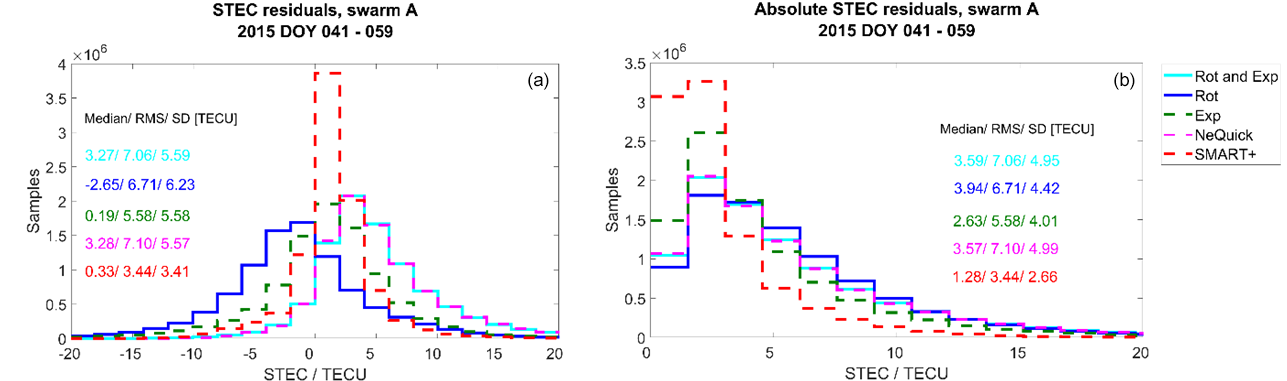
Figure 13. Histograms of the STEC residuals (a) and absolute residuals (b) during the quiet period for Swarm A.